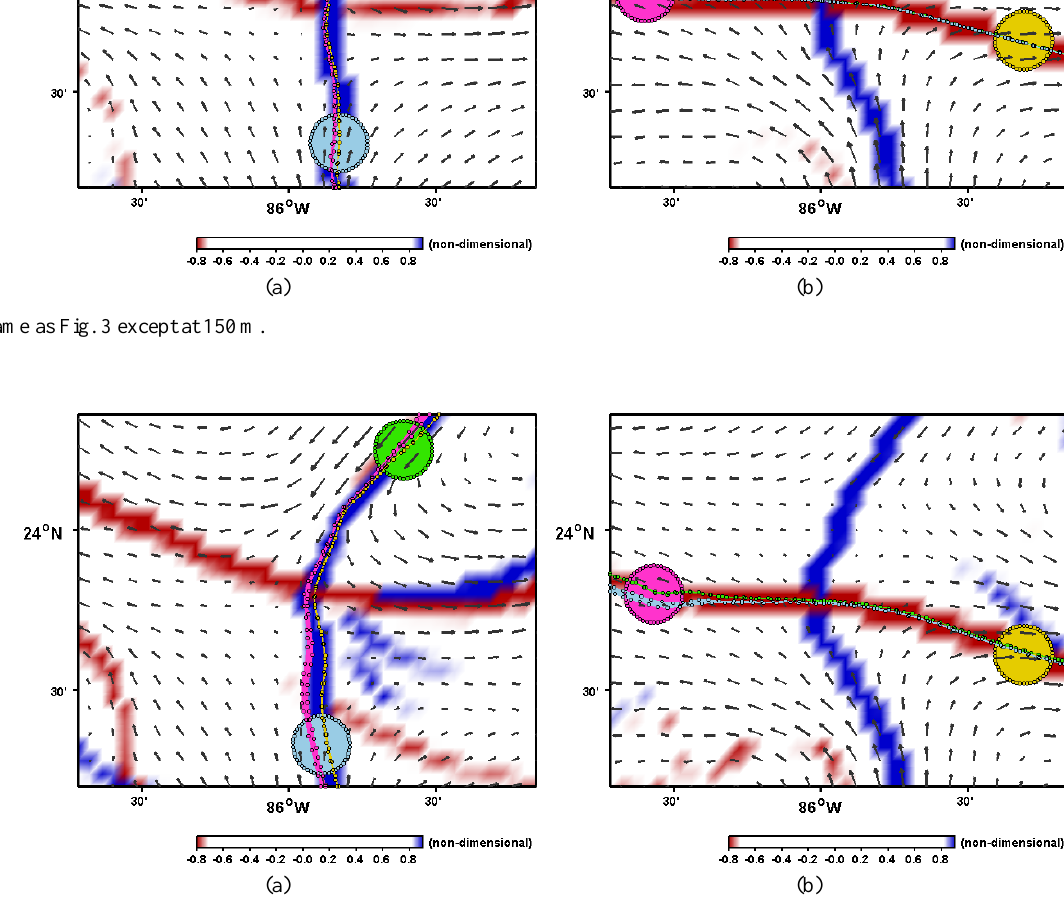
Fig. 6. Same as Fig. 3 except at